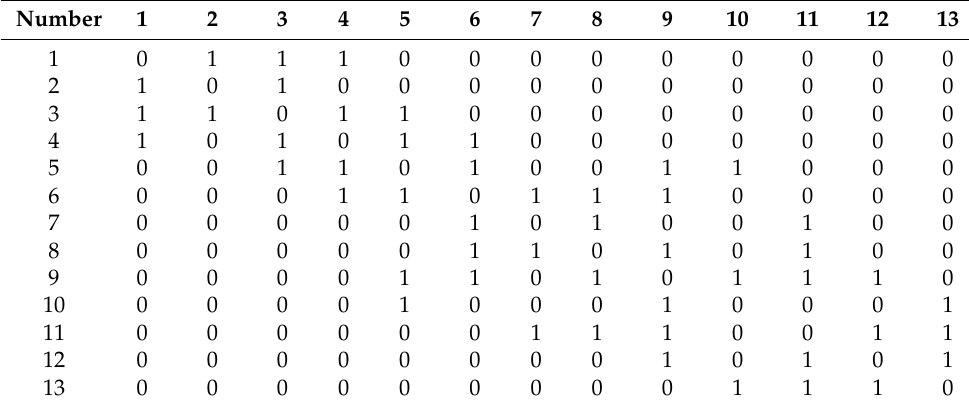
Table 4. Adjacency matrix of cities in Jiangsu Province.